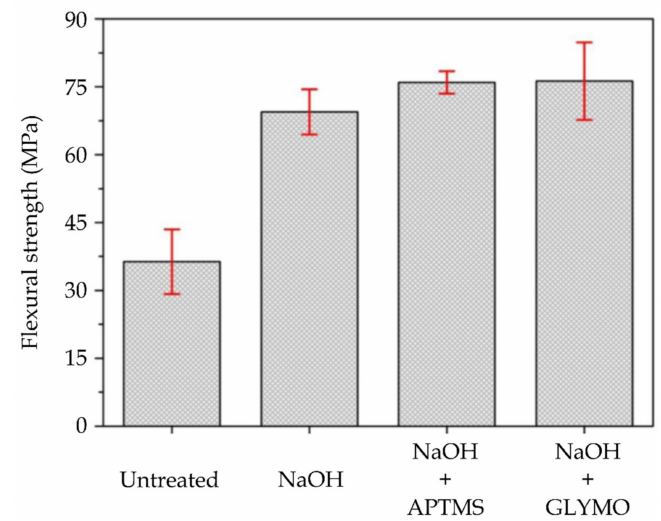
Figure 3. Bar plot of the flexural strength of PO fibreboards with different surface